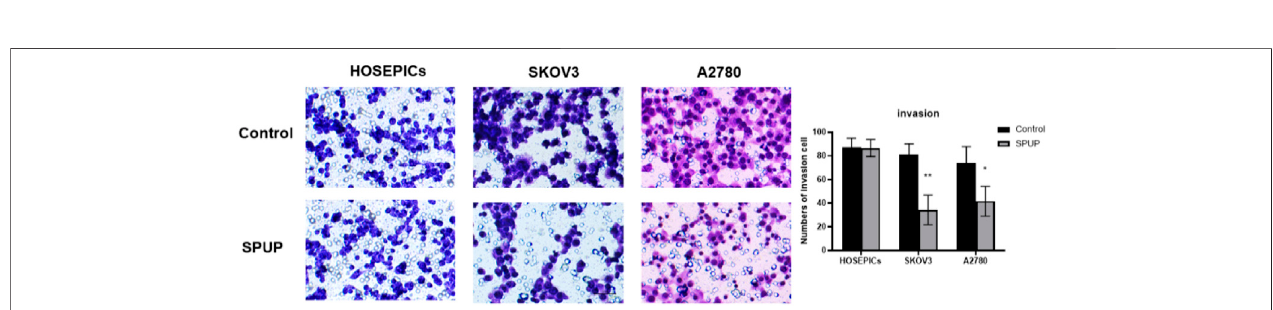
FIGURE4| SPUPontheinvasionabilityoftwokindsofOCcellsandhumannormalovarianepithelialcells.Compared withthecontrolgroup,* p < 0.05,** p < 0.01.